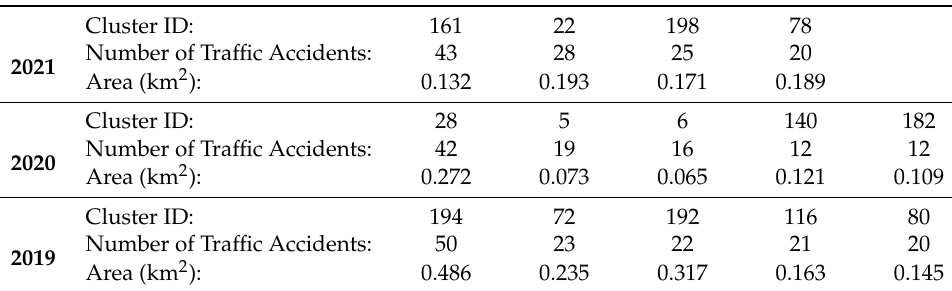
Table 4. Description of the selected clusters obtained when the introduced algorithm was applied to publicly available data on traffic accidents with injuries or death that occurred in the municipality of Zvezdara during 2021, 2020, and 2019,